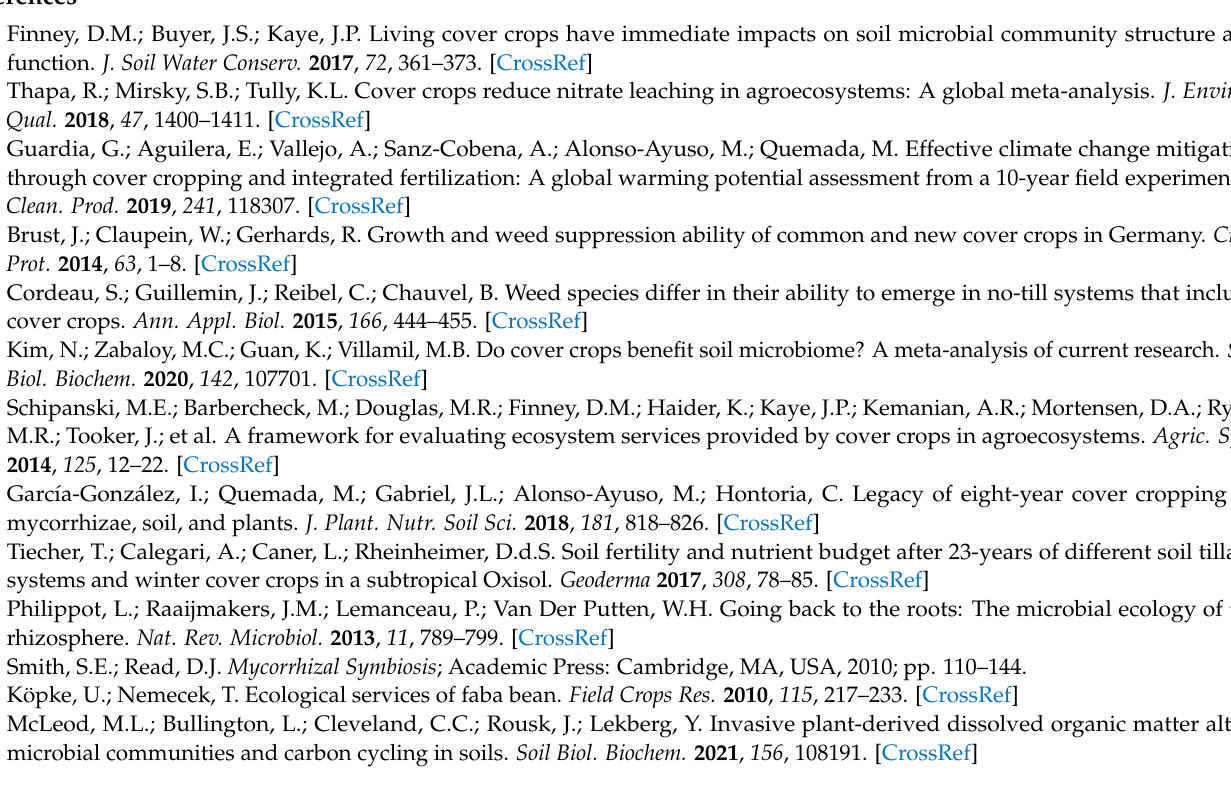
cover crops. Table S2: Shoot biomass of cover crops. Table S3: Cash crops germination after the different cover crops. Table S4: Summary of the ANOVA significance levels of the study factors and their interaction. Table S5: Macro y micronutrient content in maize shoots after the different cover crops. Table S6: Soil macro and micronutrients in wheat treatment after the different cover crops. Table S7: Soil macro and micronutrients in maize treatment after the different cover